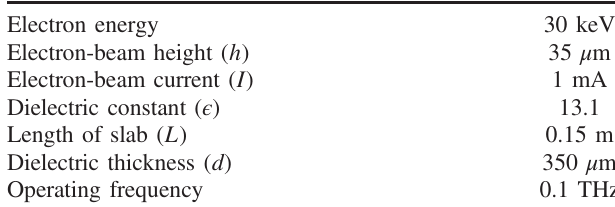
TABLE I. Parameters of a CFEL used in the calculation. Electron energy 30 keV Electron-beam height ( h ) 35 μ m Electron-beam current ( I ) 1 mA